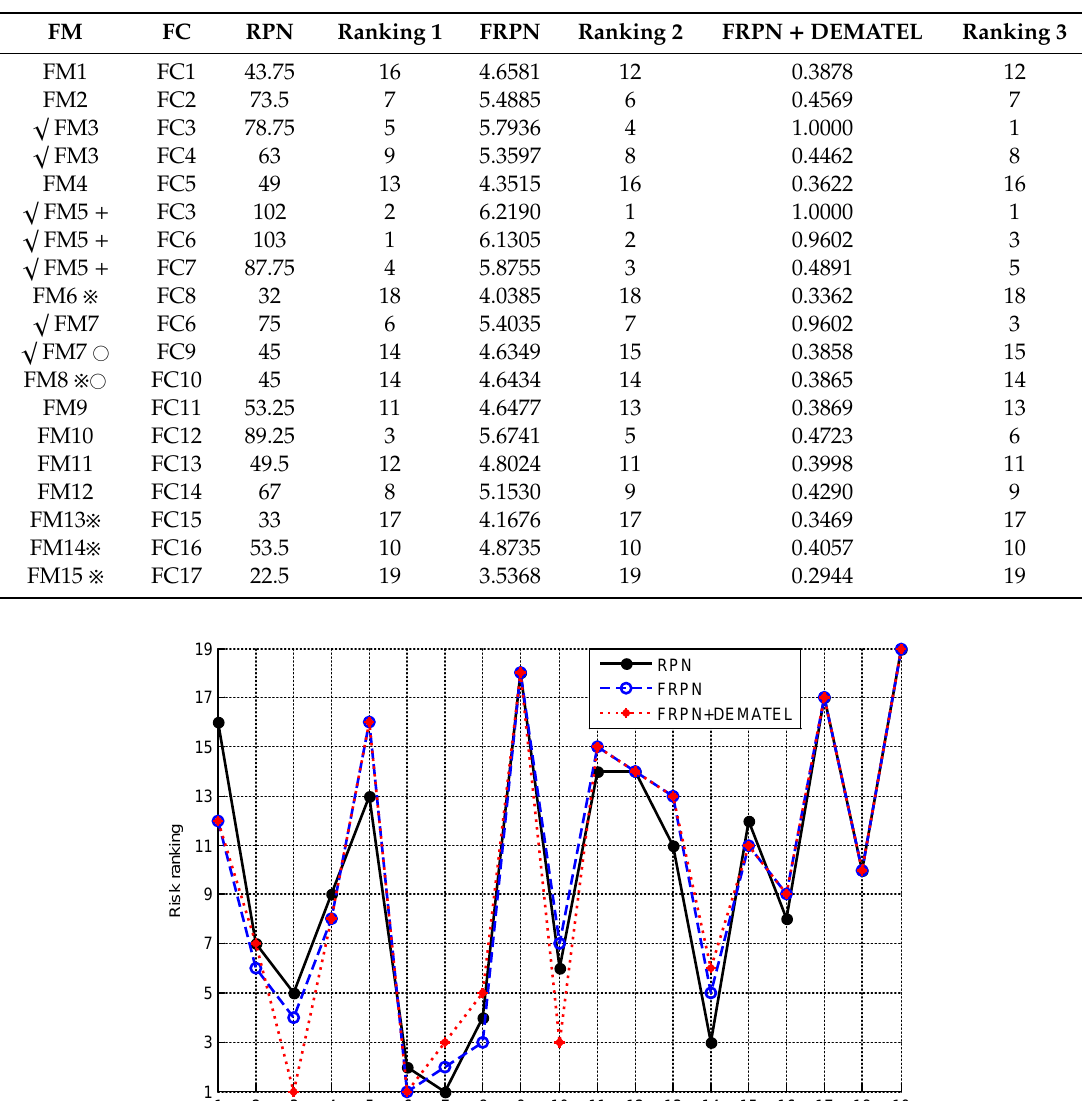
Table 9. Results comparison of the three evaluation methods. FRPN, fuzzy RPN.